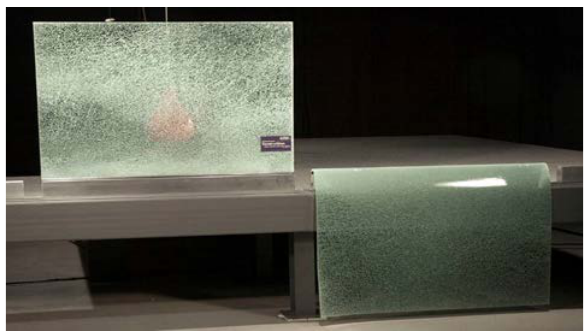
Fig. 1: Comparison of Structural Interlayer vs Standard PVB after Breakage (2 x 6 mm fully tempered and 1.52 mm interlayer) Today there are two types of structural interlayers, stiff PVB and Ionoplast interlayer. Stiff PVB are based on